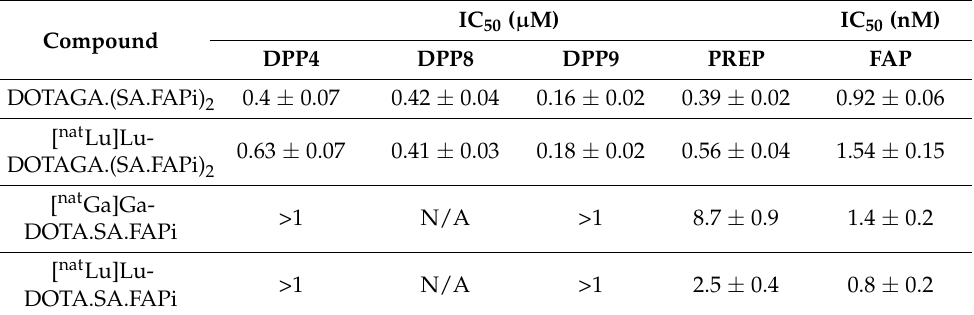
Table 1. IC 50 values for FAP and the related serine proteases (PREP, DPP4, DPP8, DPP9). (Adapted from ref.